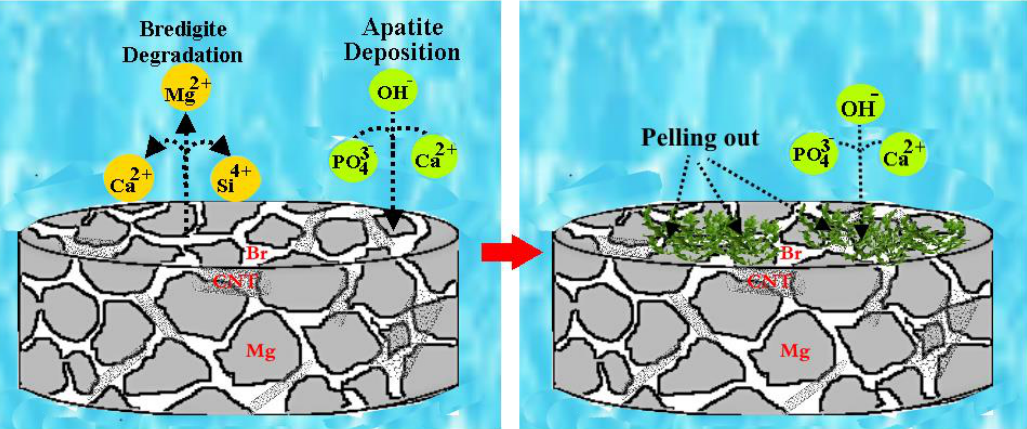
Figure 11. Schematic diagram of bridigite fracture and apatite formation in SBF